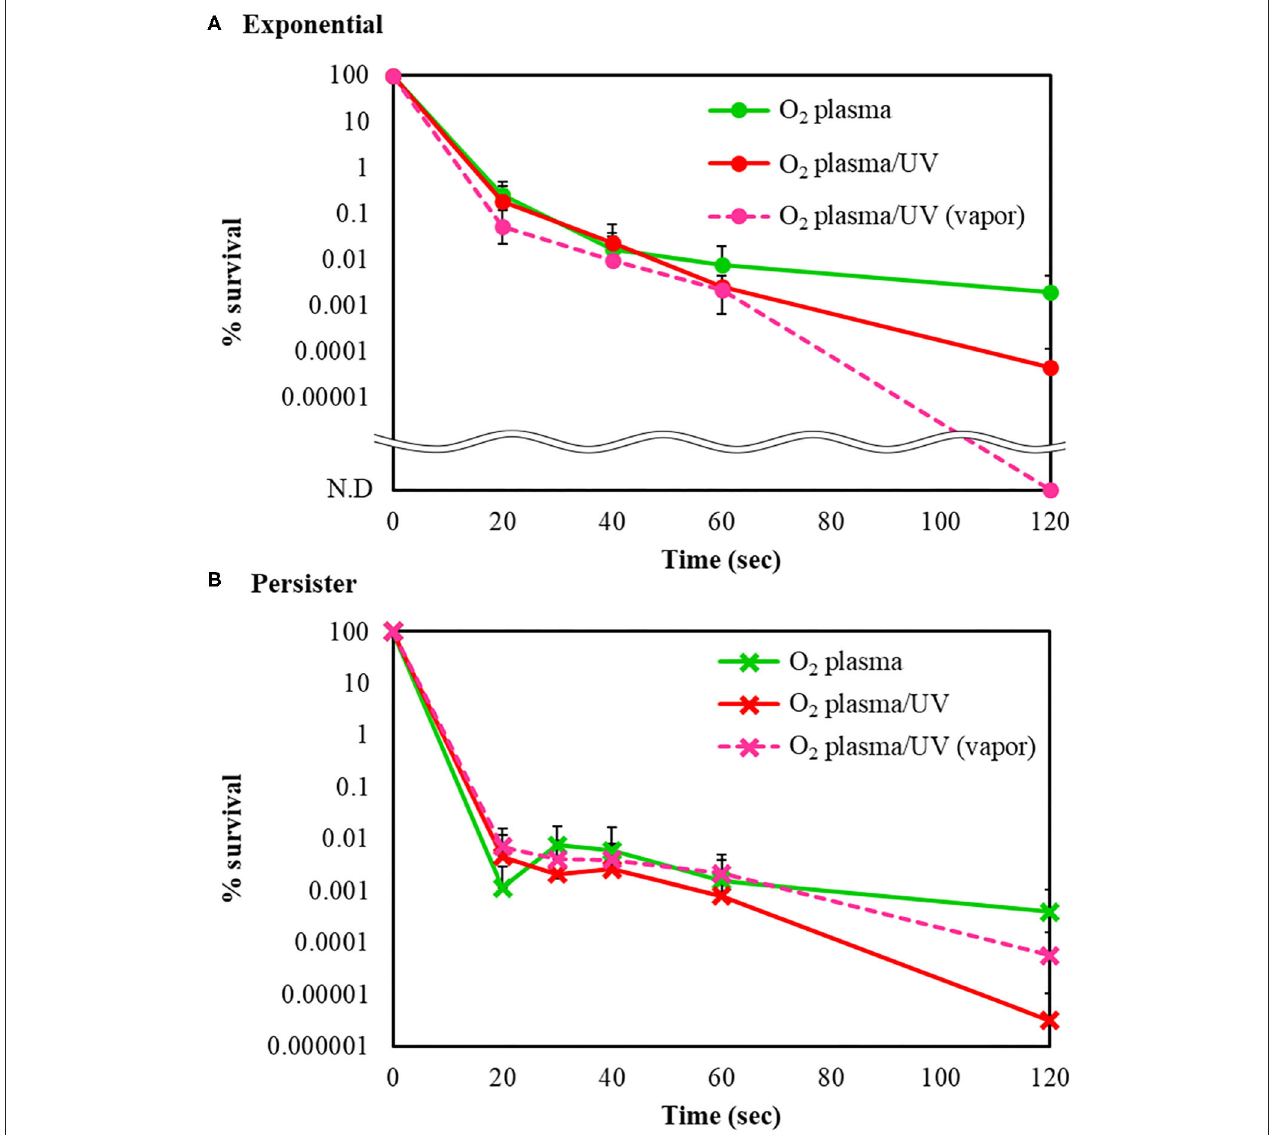
FIGURE 5 | Bactericidal effects of other radical vapor reactor (RVR) conditions. Survival rate of (A) E. coli exponential cells and (B) E. coli persister cells after sterilization with O 2 plasma (green), O 2 plasma/UV (red), and O 2 plasma/UV with vapor (pink, broken line) modes. Each exponential or persister cell sample was plated on M9 agar and treated in each RVR mode. Non-detectable bacterial numbers are indicated as N.D. Error bars indicate S.D. of at least three experiments. The values obtained in these experiments are shown in Supplemental Table 3